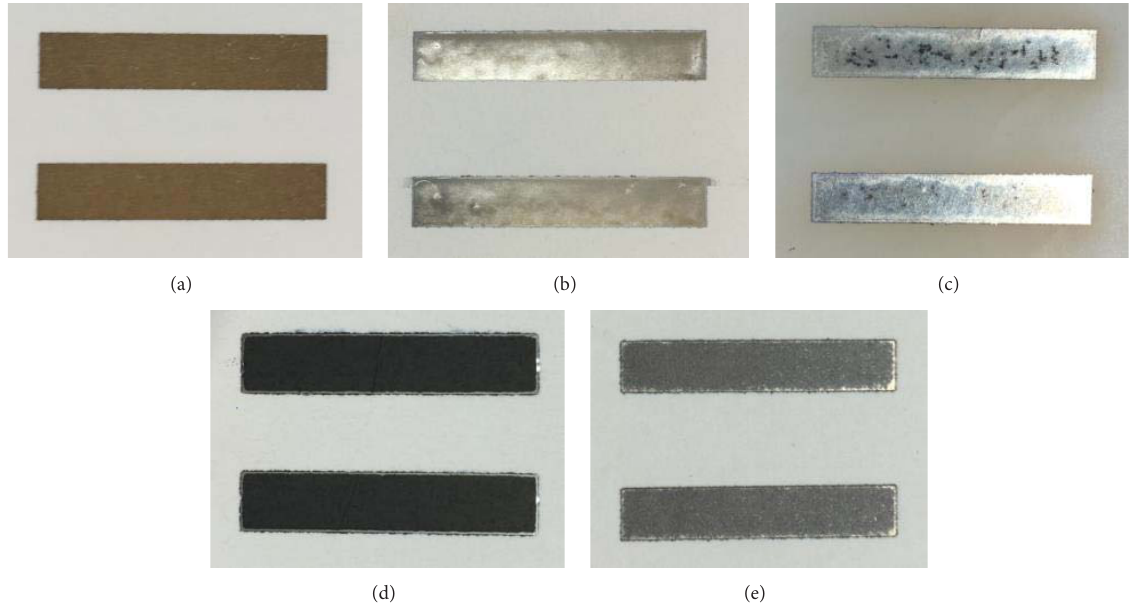
Figure 3: Inkjet-printed line patterns for fabrication optimization: (a) four-layer lines on Paper B, (b) four-layer lines on Paper A, (c) four- layer lines on Paper C, (d) four-layer lines on Cardboard A, and (e) four-layer lines on Cardboard B.